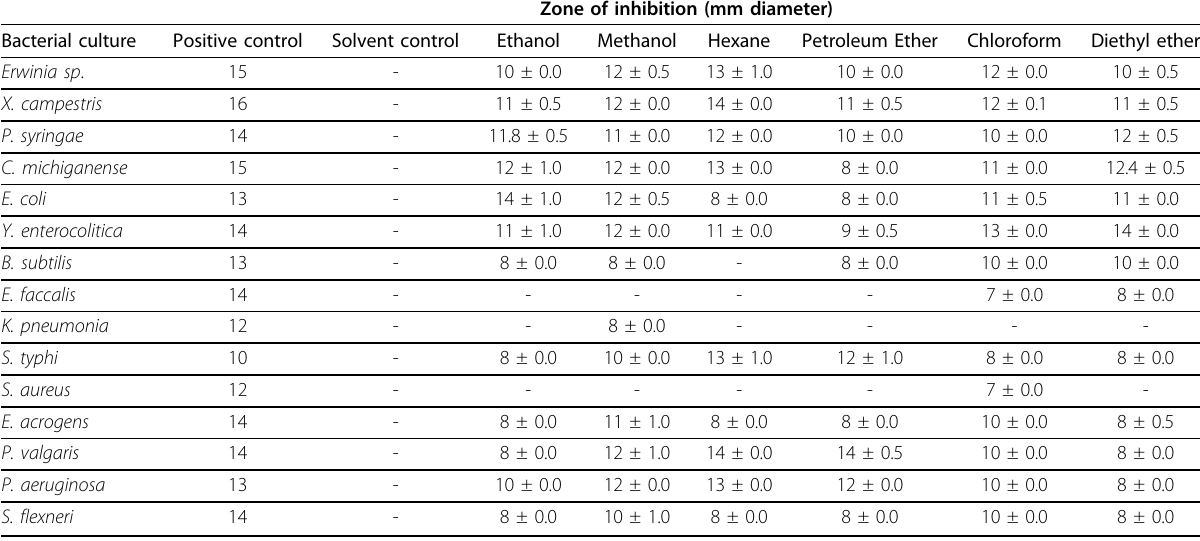
Zone of inhibition (mm diameter)